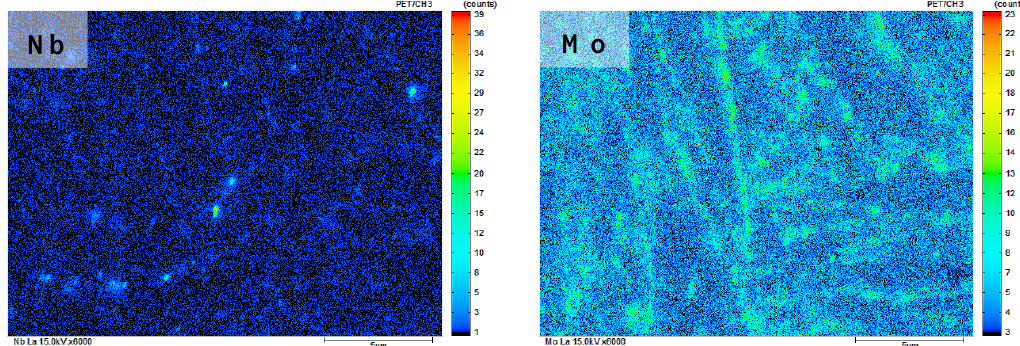
Figure 9. Analysis results of elements in 9Cr–1.5Mo–1Co heat-resistant steel.